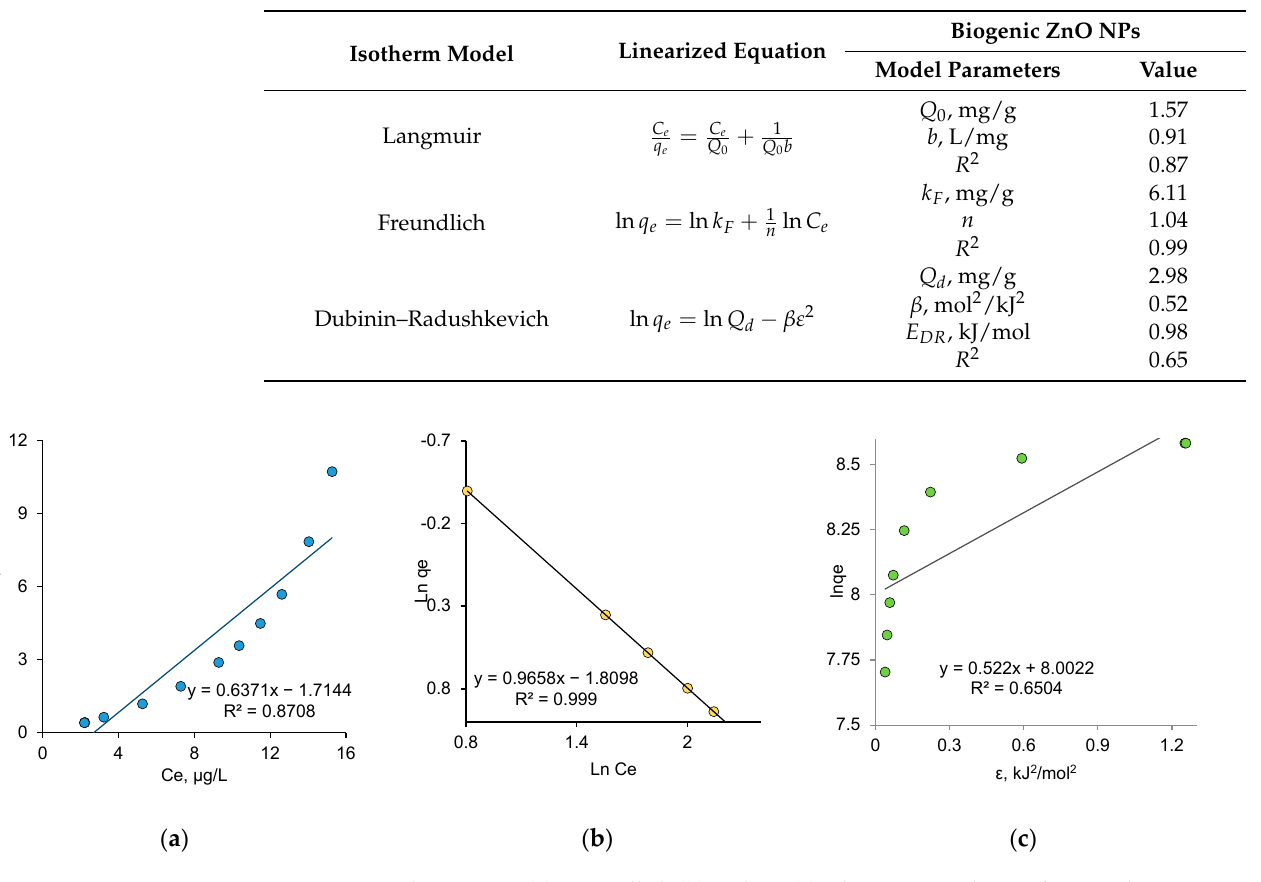
Figure 9. Fitted Langmuir ( a ), Freundlich ( b ) and DR ( c ) adsorption isotherms for AY adsorption on biogenic ZnO NPs.